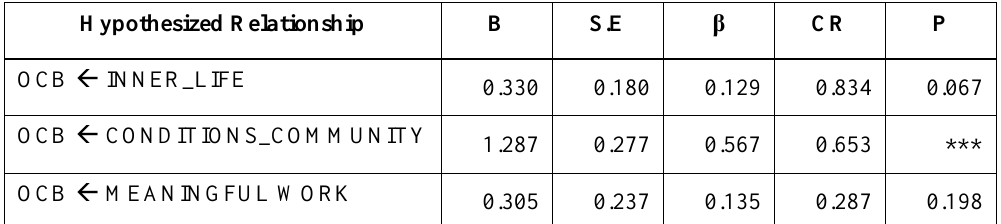
Table 3. Unstandardized (B) and Standardized Regression (β) Weight in